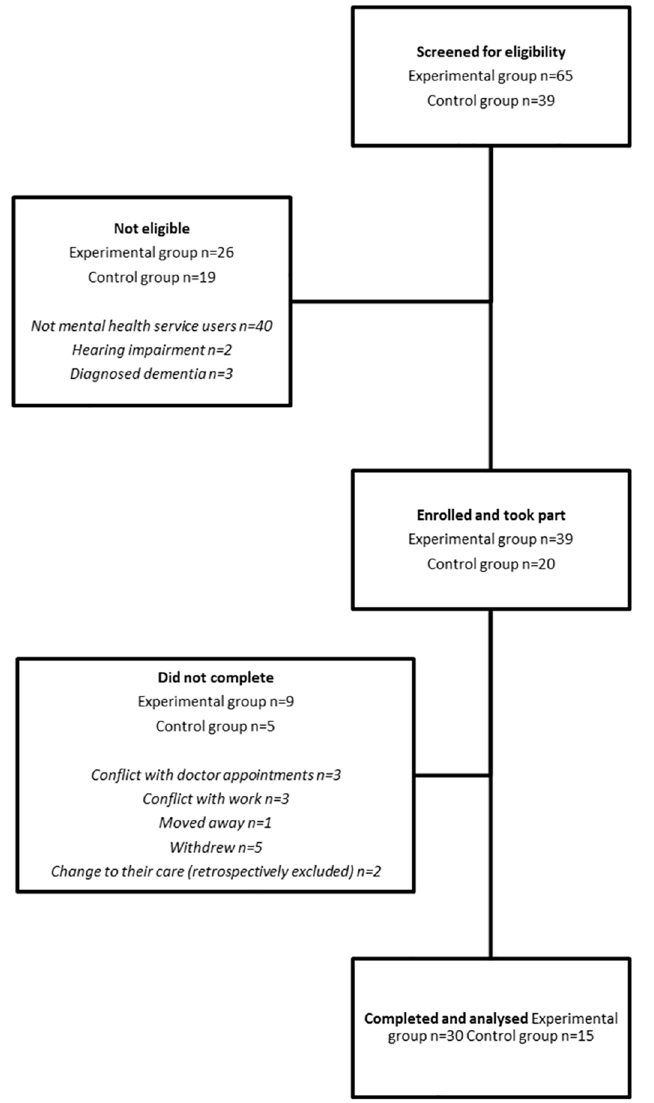
Fig 1. Flow of participants involved in the study.